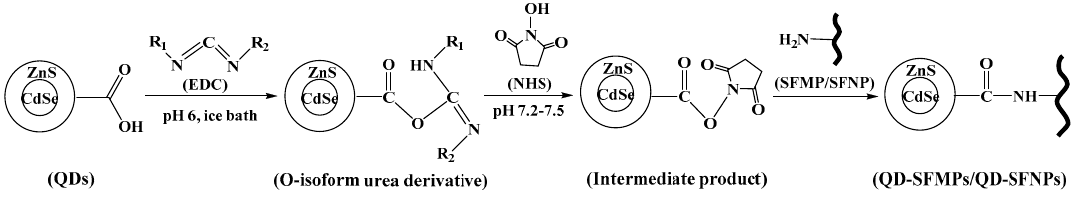
Figure 3. Schematic illustration of Quantum dot (QD)-labeled silk fibroin particles.